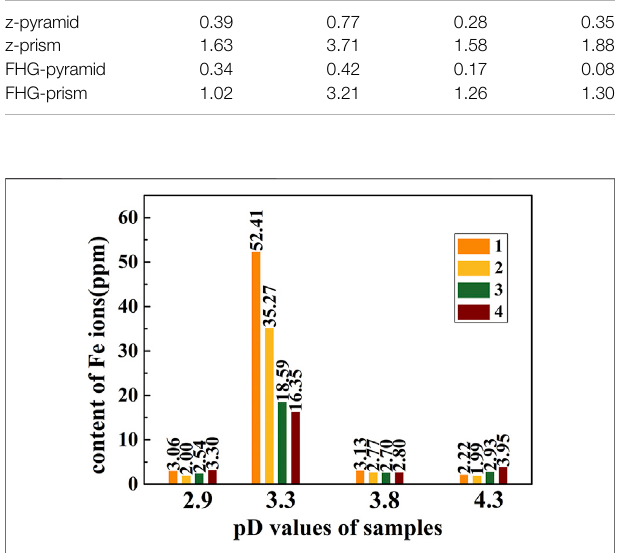
FIGURE 7 | The content of Fe ions (ppm) in prismatic